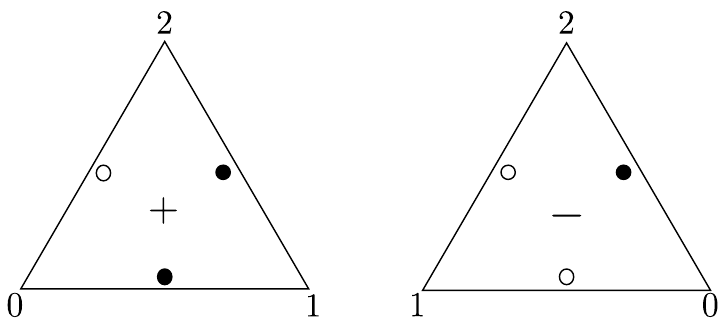
Figure 1 . Assignment of Grassmann variables on 1-simplices in the case of d = 2. (cid:18) (resp. (cid:18) ) is represented as a black (resp. white)